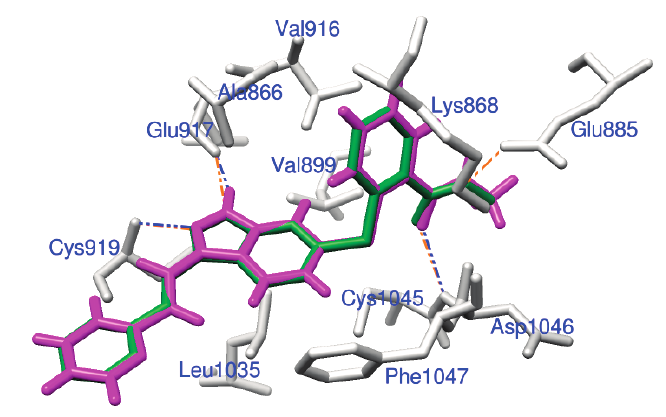
Figure 1. Docking validation, a comparison of the redocked binding mode (magenta) and the co-crystallized pose (forest green) of axitinib. Related residues of VEGFR-2 are labeled and shown as sticks in light gray. Hydrogen bonds are illustrated as dashed lines, blue for redocked mode and orange for co-crystallized